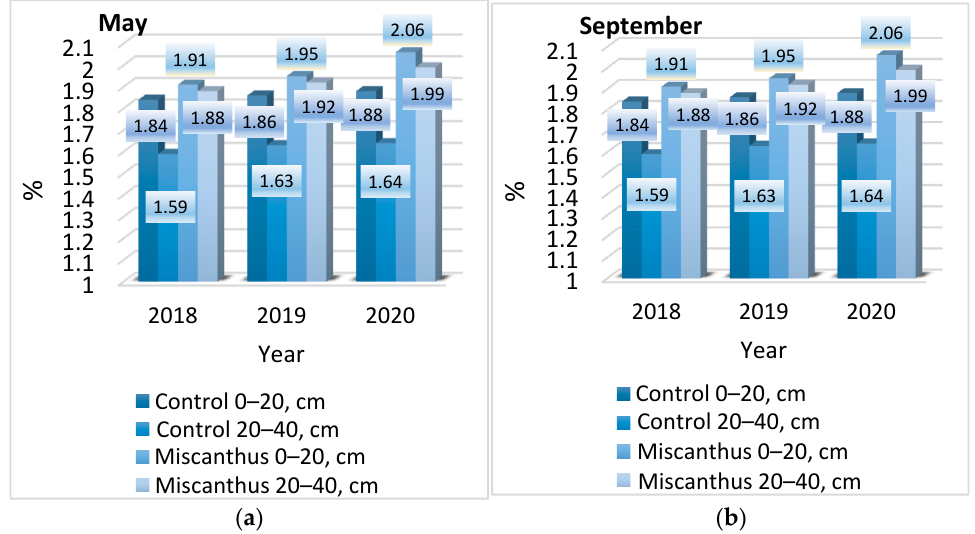
Figure 4. Carbon content in organic matter of chernozem, May ( a )–September ( b ) 2018–2020, in %. Source: own research results.